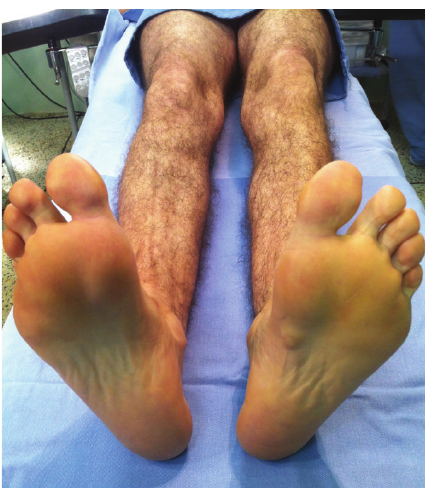
Figure 1: Nodules in the plantar aponeurosis of the left foot.